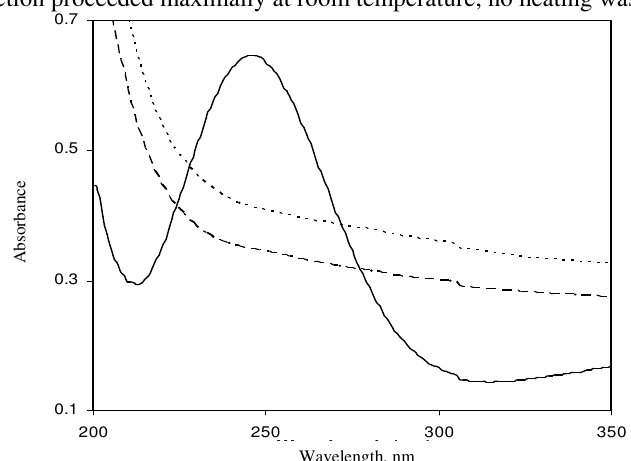
Figure 1. Absorption spectra of the complex formed through reaction of: 75 µ g mL -1 gabapentin with cupric chloride in presence of borate buffer pH 7.5, 75 µ g mL -1 gabapentin with borate buffer pH 7.5, cupric chloride with borate buffer pH 7.5